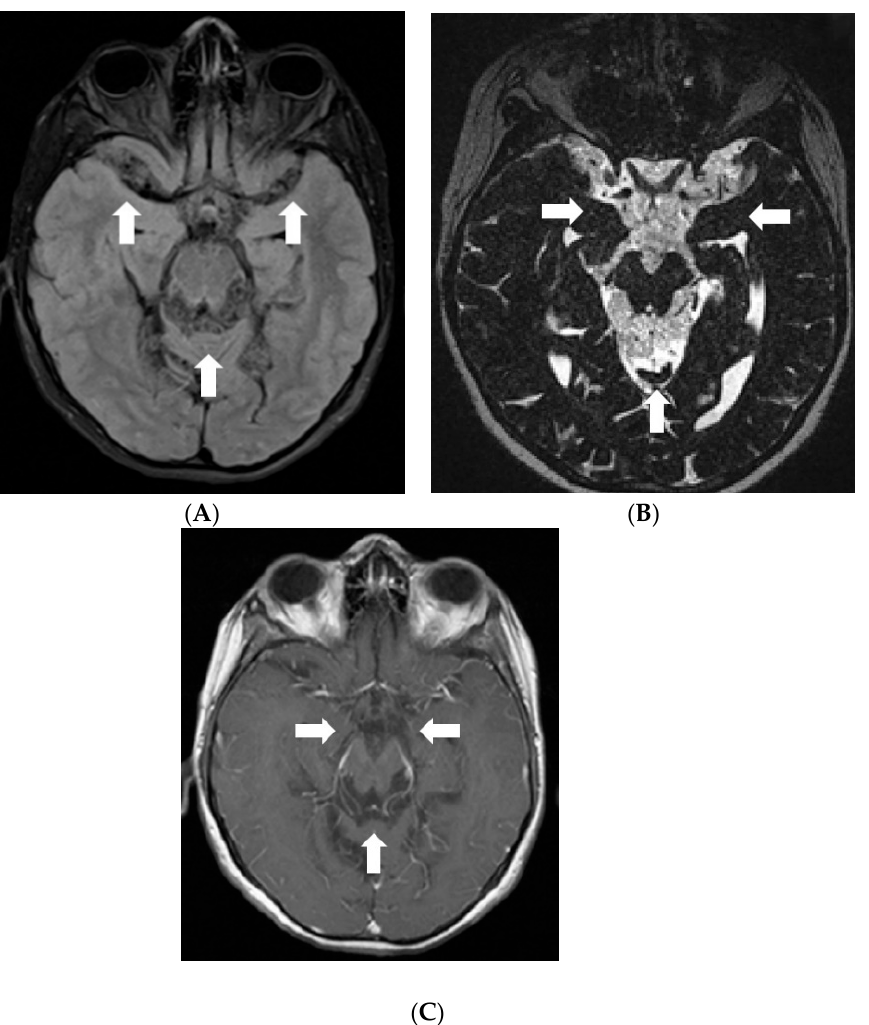
Figure 3. Follow-up MRI of the brain 1 year after the onset of the symptoms (April 2012): ( A ) Axial T2W/FLAIR/FS and ( B ) T2W/SPC images disclose masses composed of multiple small cysts in the subarachnoid cisterns, Sylvian fissures, and cerebellar sulci. There is no contrast enhancement ( C ) in the referred areas.